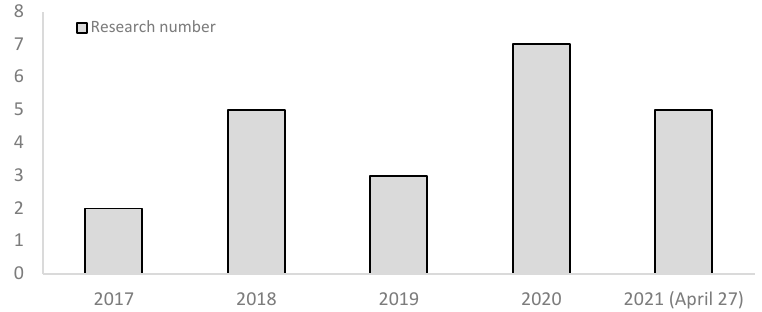
Figure 2. Chronological publication analysis in the data range 2010-2021.